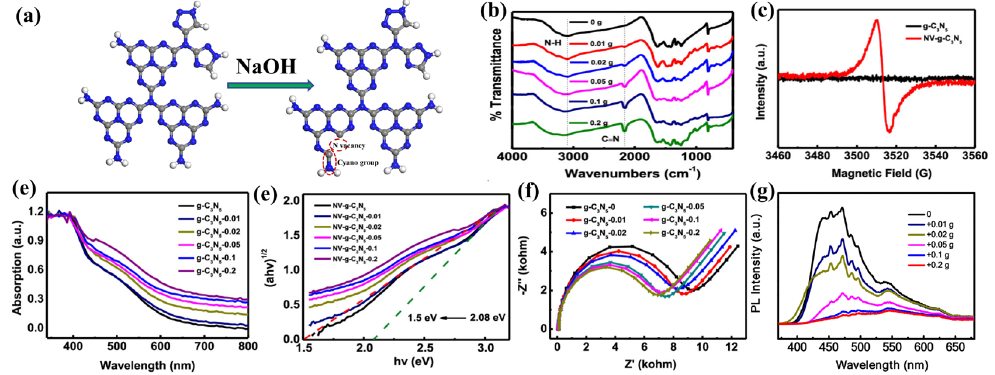
Figure 9. ( a ) Structures of g-C 3 N 5 and N V -g-C 3 N 5 ; ( b ) FT-IR spectra; ( c ) ESR spectra; ( d ) UV-vis spectra; ( e ) Tauc’s Plots; ( f ) EIS spectra; ( g ) FL spectra of g-C 3 N 5 and N V -g-C 3 N 5 (0.01, 0.02, 0.05, 0.1, and 0.2 represent the amounts of NaOH for vacancy production). ( b – f ) Adapted with permission from [41]. Copyright American Chemical Society,